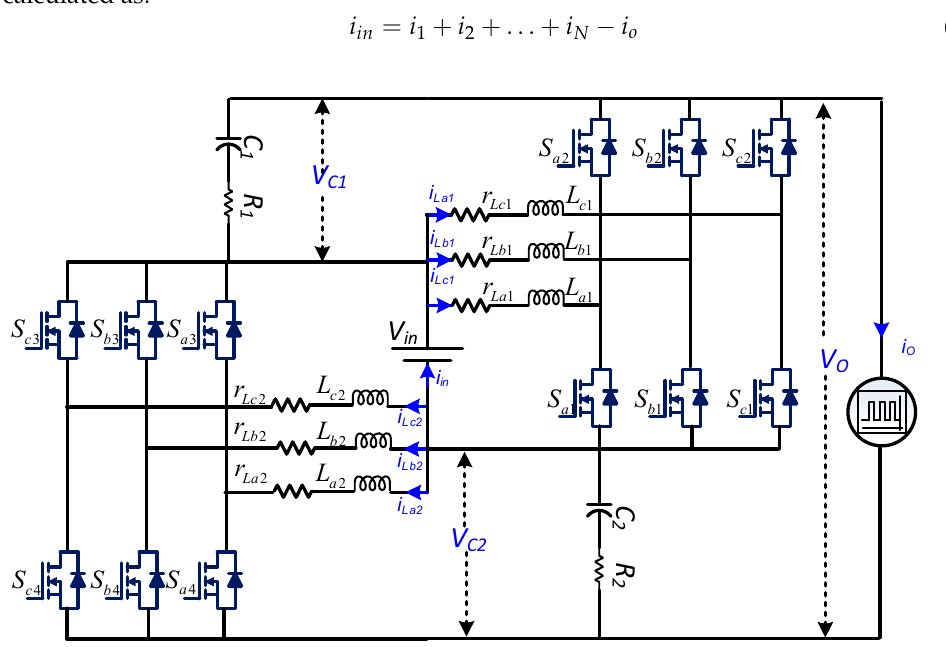
Figure 4. Multiphase IMPCCB.